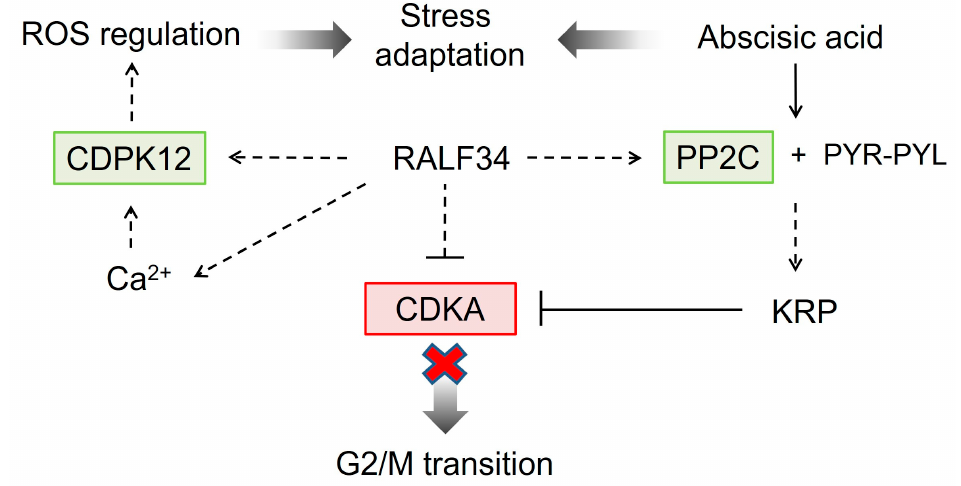
Figure 10. Signaling pathway involved in the regulation of the cell cycle and response to abiotic stress was activated in CsRALF34 overexpressors. The up- or downregulated proteins are marked by green and red color, respectively. The pathway mapping relied on the KEGG signal pathway database, Shimotohno et al. [48], Dekomah et al. [49], and Asano et al. [50]. CDKA, cyclin-dependent kinase A (2.7.11.22); CDPK12, calcium-dependent protein kinase 12 (2.7.11.1); PP2C, protein phosphatase 2C (3.1.3.16); PYR-PYL, pyrabactin resistance, pyrabactin resistance-like component of abscisic acid receptor; ROS, reactive oxygen species; KRB, kip-related protein. Narrow arrows indicate individual steps of a pathway, dotted arrows indicate several steps of a pathway, while broad arrows point to the final effect of a pathway.